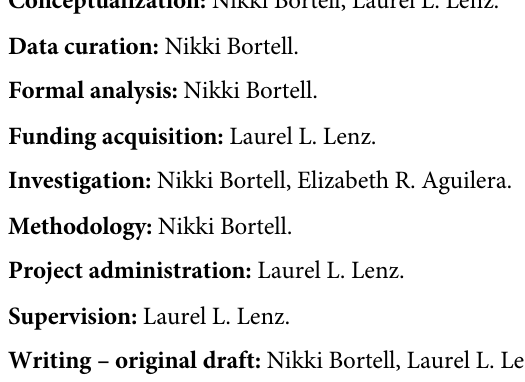
S11 Fig. Flow cytometry plots for detection of Il10-gfp reporter staining in lymphocytes. Representative flow cytometry plots from the spleens of B6. tiger ( Il10 -gfp reporter) mice infected with sham control, Lm PO, L1S IT, or L1S IT + Lm PO and harvested at 3 dpi. (TIF) S12 Fig. Peripheral Lm burdens upon co-treatment with alternative pulmonary stimuli. C57BL/6J (B6) male and female age-matched mice were infected with Lm PO or 10 6 HK Spn IT + Lm PO, and CFUs were determined 3 dpi. Lm burdens were enumerated from (A) spleens, (B) livers, and (C) lungs. Data are represented as mean ± SD, Mann-Whitney t-test, pooled from 3 experiments, with 10–12 mice per group, ���� p < 0.0001 between indicated groups. B6 male and female age-matched mice were infected with Lm PO, or co-treated with 50ug LPS IT + Lm PO, 50ug poly:IC IT + Lm PO, or 50ug Pam3CSK4 IT + Lm PO and CFUs were determined 3 dpi. Lm burdens were enumerated from (D) spleens, (E) livers, and (F) lungs. Data are represented as mean ± SD, Mann-Whitney t-test, pooled from 2 experiments, with 8–10 mice per group, �� p < 0.002, ��� p < 0.0002, ���� p < 0.0001 between indicated groups. C57BL/6J (B6) and Ncr1 iCre x Il10 fl/fl male and female age-matched mice were infected with Lm PO, 10 6 HK Spn IT + Lm PO, or 50ug LPS IT + Lm PO and harvested at 3 dpi. Lm burdens were enumerated from (G) spleens, (H) livers, and (I) lungs. Data represent mean ± SD, Mann-Whitney t-test, pooled from 2 experiments, 4–8 mice per group. �� p < 0.002, ��� p < 0.0002, between indicated groups, #p < 0.05, ##p < 0.001 between indicated co-treated Ncr1 iCre x Il10 fl/f mice and B6 Lm PO infected mice.